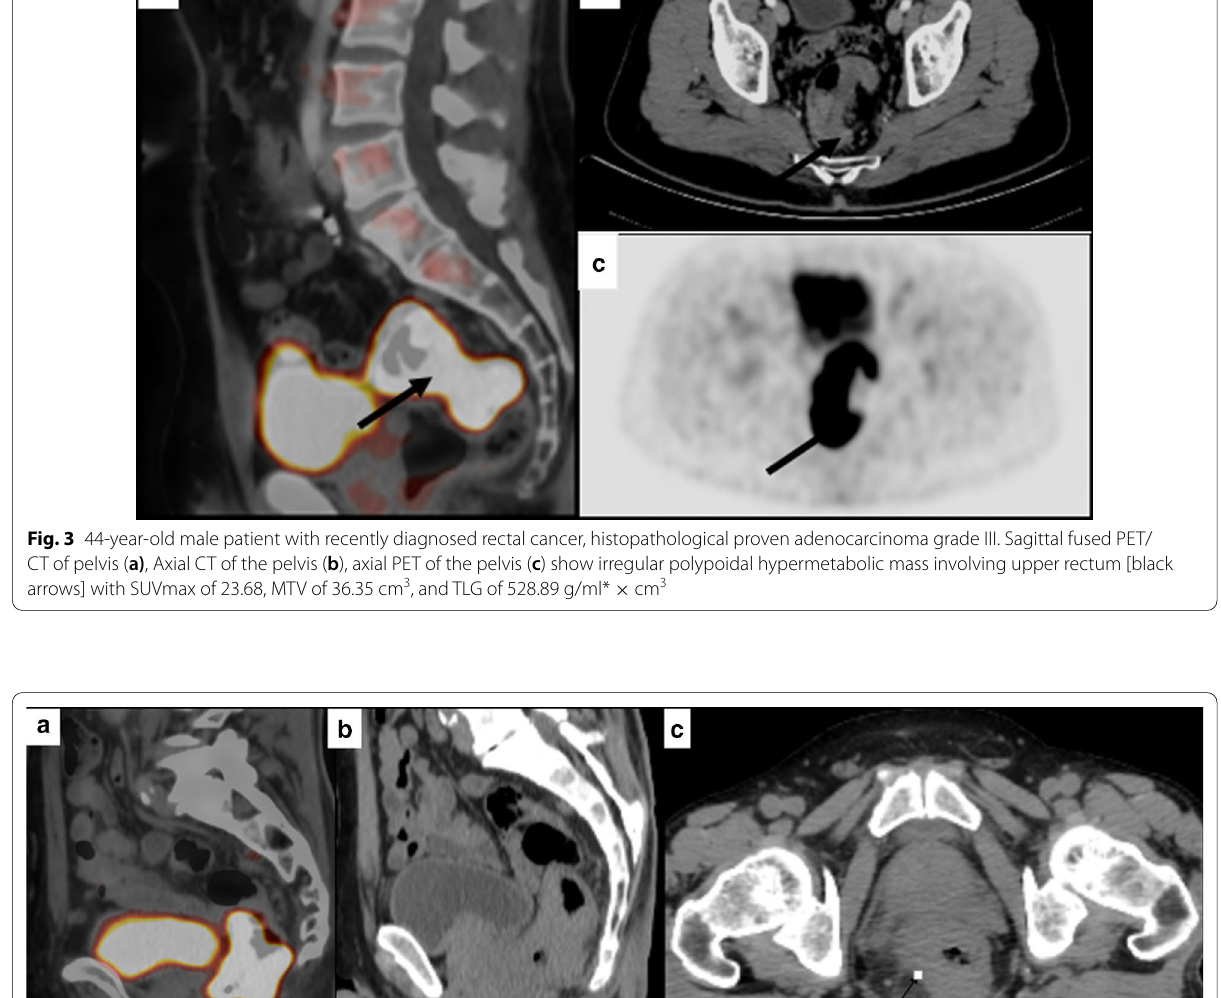
Fig. 4 67-year-old male patient with recently diagnosed rectal cancer, histopathological proven adenocarcinoma grade II. Sagittal fused PET/ CT of the pelvis ( a ), Sagittal CT of the pelvis ( b ), and axial CT ( c ) show metabolically active focal mural thickening at the lower rectum [thin arrow] achieving SUVmax 22.3, MTV of 30.46 cm 3 , and TLG of 422.7 g/ml* cm 3 . Few small inactive perirectal lymph nodes [thick ×